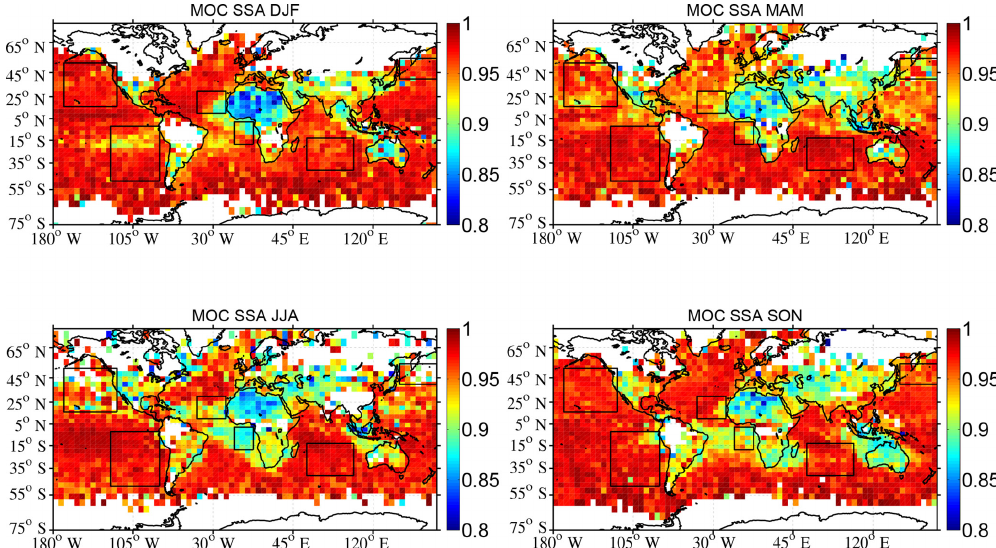
Figure A1. Seasonal maps of MOC SSA at 546.3nm in 2007 used in the calculations of DARE OWC . The squares show different regions defined in Table 5.